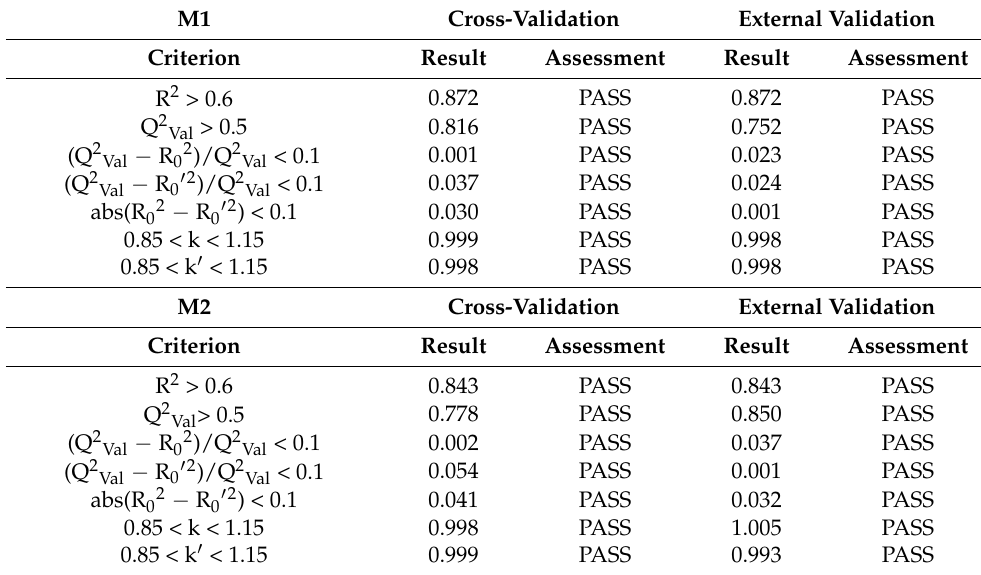
Table 2. Validation based on the Tropsha’s test for M1 and M2. Val is the abbreviation of validation. M1 Cross-Validation External Validation